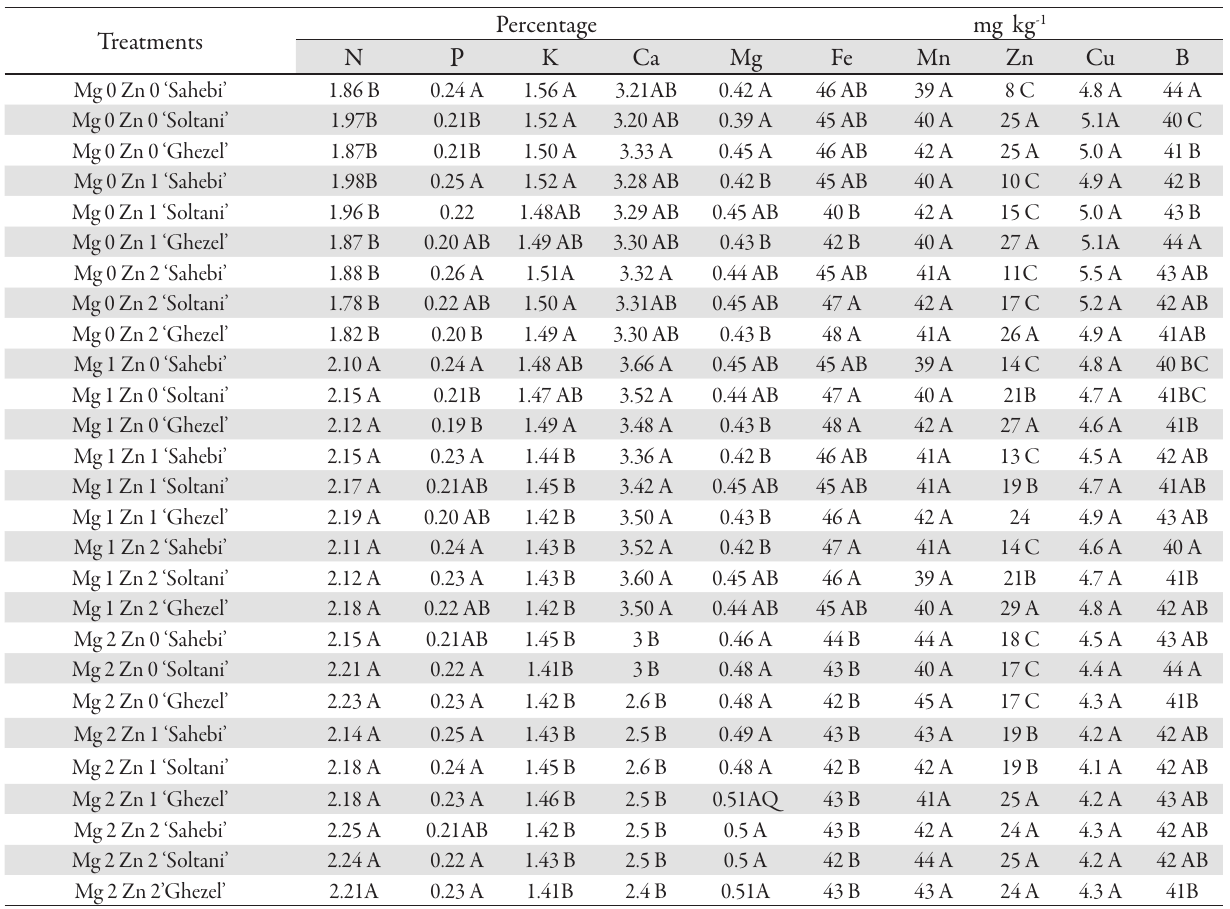
Tab. 3. Effects of different treatments on grape leaf nutrient concentrations Treatments